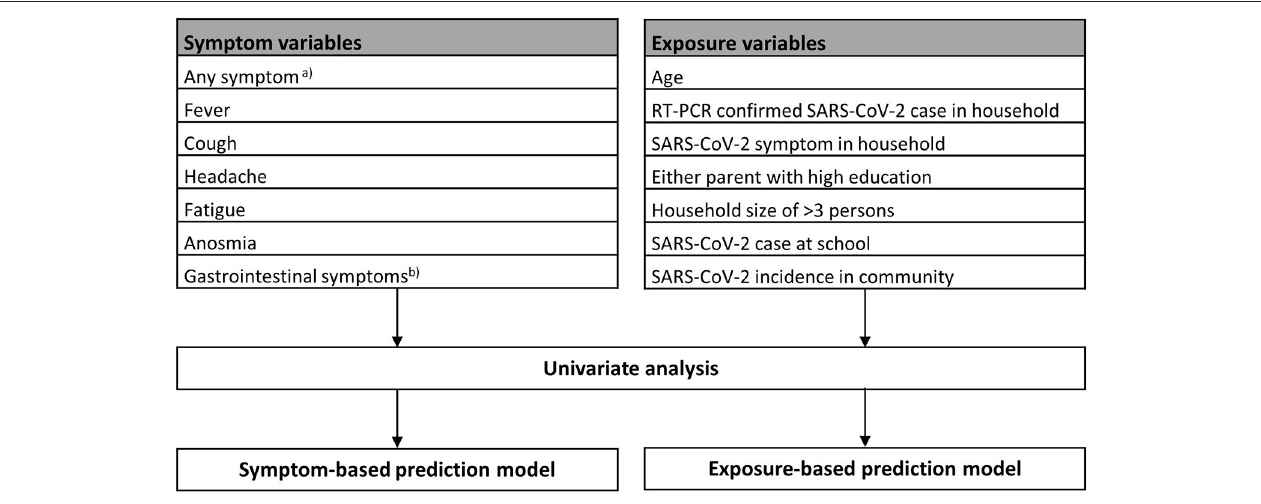
FIGURE 3 | Univariate and multivariable logistic regression analyses of symptom and exposure variables at T1 and T2. a Any of the following symptoms: fever, cough, runny nose, sneezing, sore throat, shortness of breath, headache, myalgia, fatigue, loss of appetite, nausea, emesis, diarrhea, upset stomach, and anosmia. b Any of the following symptoms: loss of appetite, nausea, emesis, diarrhea, and upset